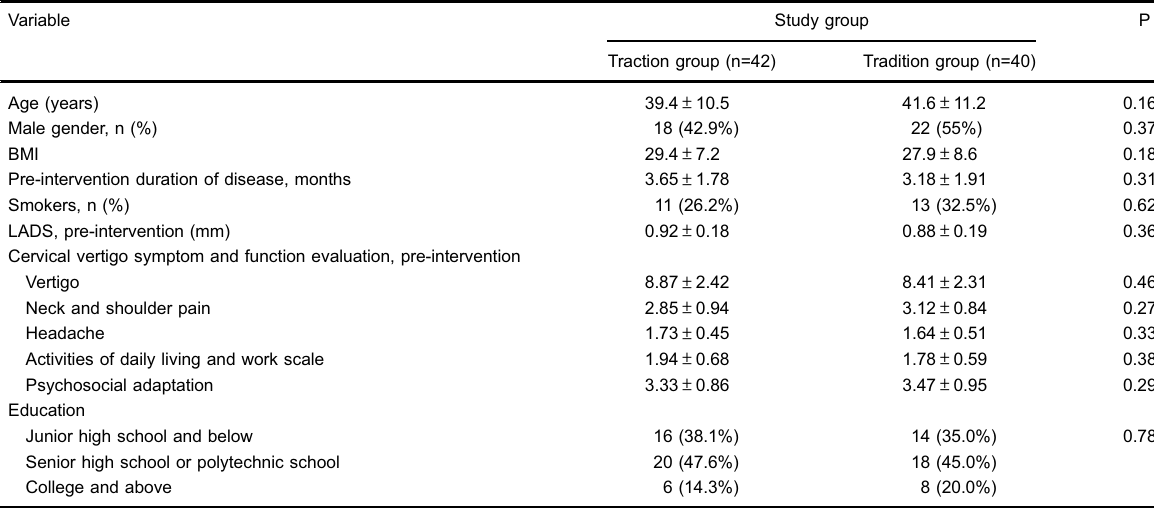
Figure 2. Flowchart of this study. Table 1. Demographic characteristics of the included